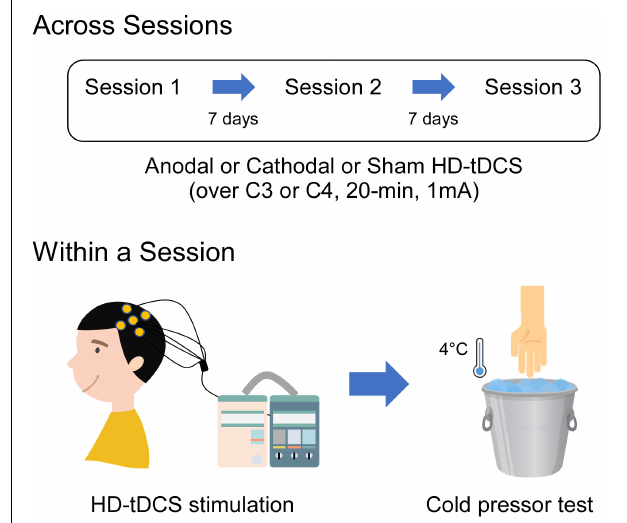
FIGURE 1 | Schematic illustration of the experimental procedures. Each participant visited three sessions which comprised single-session tDCS intervention (1 mA, 20 min) followed by a cold pressor test. Three sessions were separated by 7 days to avoid the possible carryover effects due to the tDCS stimulation. During the tDCS intervention, participants received HD-tDCS targeted on the M1 using anodal, cathodal, or sham stimulation. HD-tDCS electrodes were placed according to the International 10–20 System, with the central electrode placed at C3 or C4 and the return electrodes placed at FC5, FC1, CP1, CP5 or FC6, FC2, CP2, CP6, respectively. During the cold pressor test, sensitivity to cold pain was measured by instructing participants to immerse their both hands (contralateral and ipsilateral to the HD-tDCS target side) into the cold-water apparatus of 4 ◦